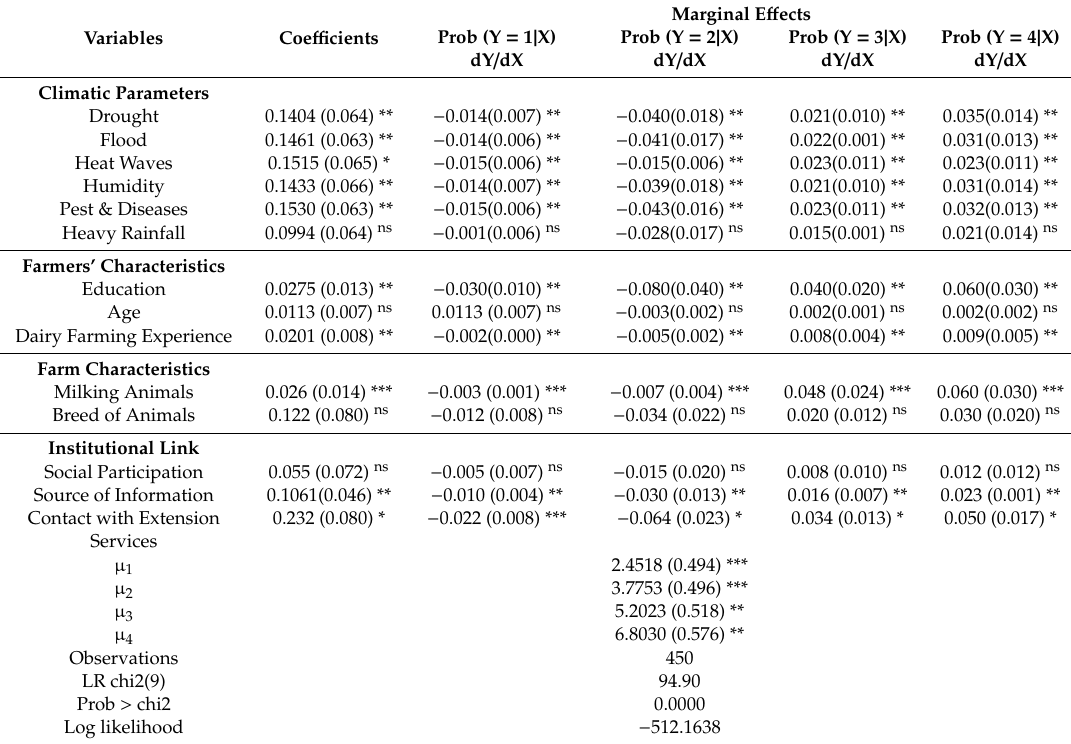
Table 3. Model results with marginal e ff